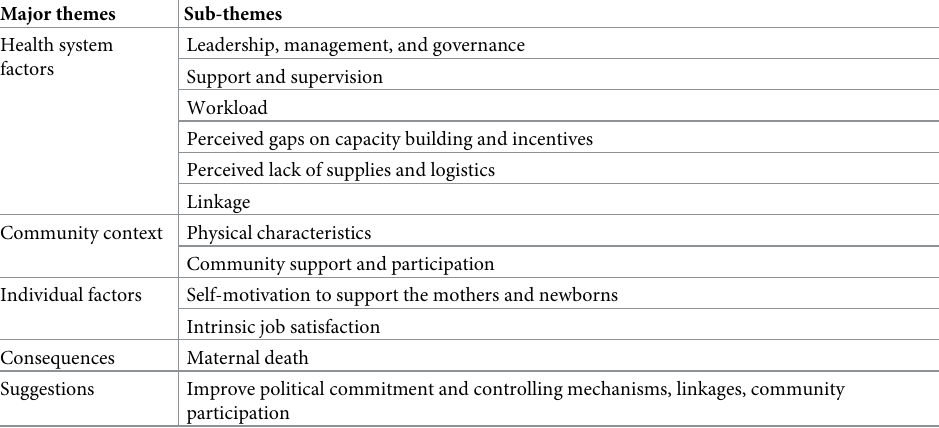
Table 3. List of themes and sub-themes emerged from the data, rural districts of Northern